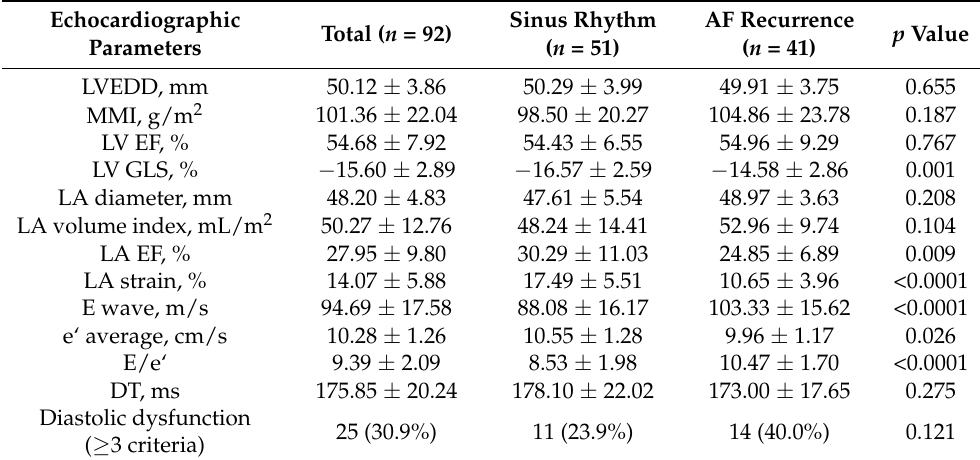
Table 2. Echocardiographic characteristics of the subjects.